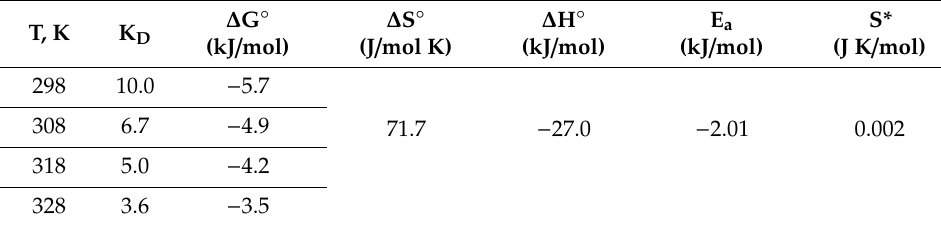
Table 4. Values of thermodynamic parameters.